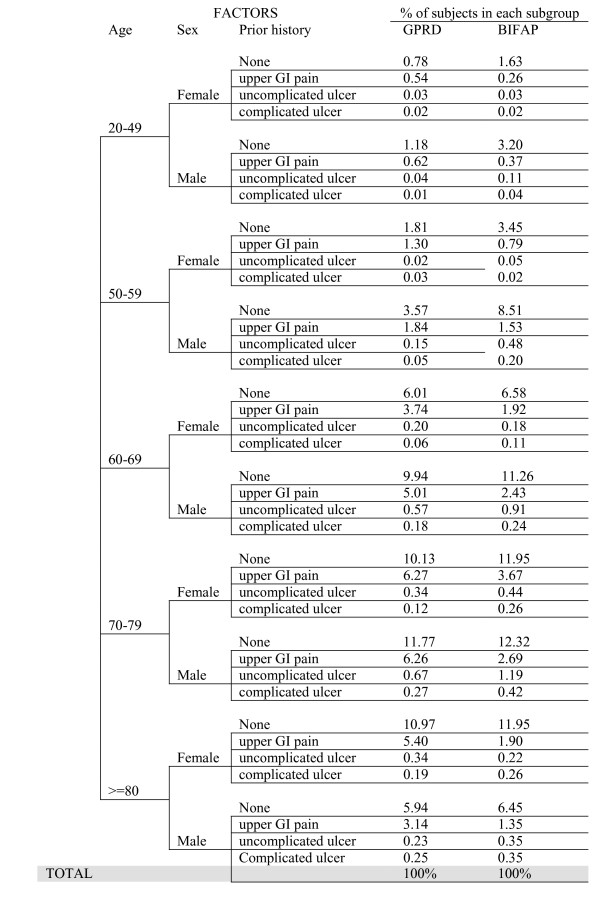
Distribution of risk factors for upper gastrointestinal tract complications (UGIC) among cardioprotective aspirin users in the UK (General Practice Research Database; GPRD) and Spain (Base de Datos para la Investigación Farmacoepidemiológica en Atención Primaria; BIFAP).